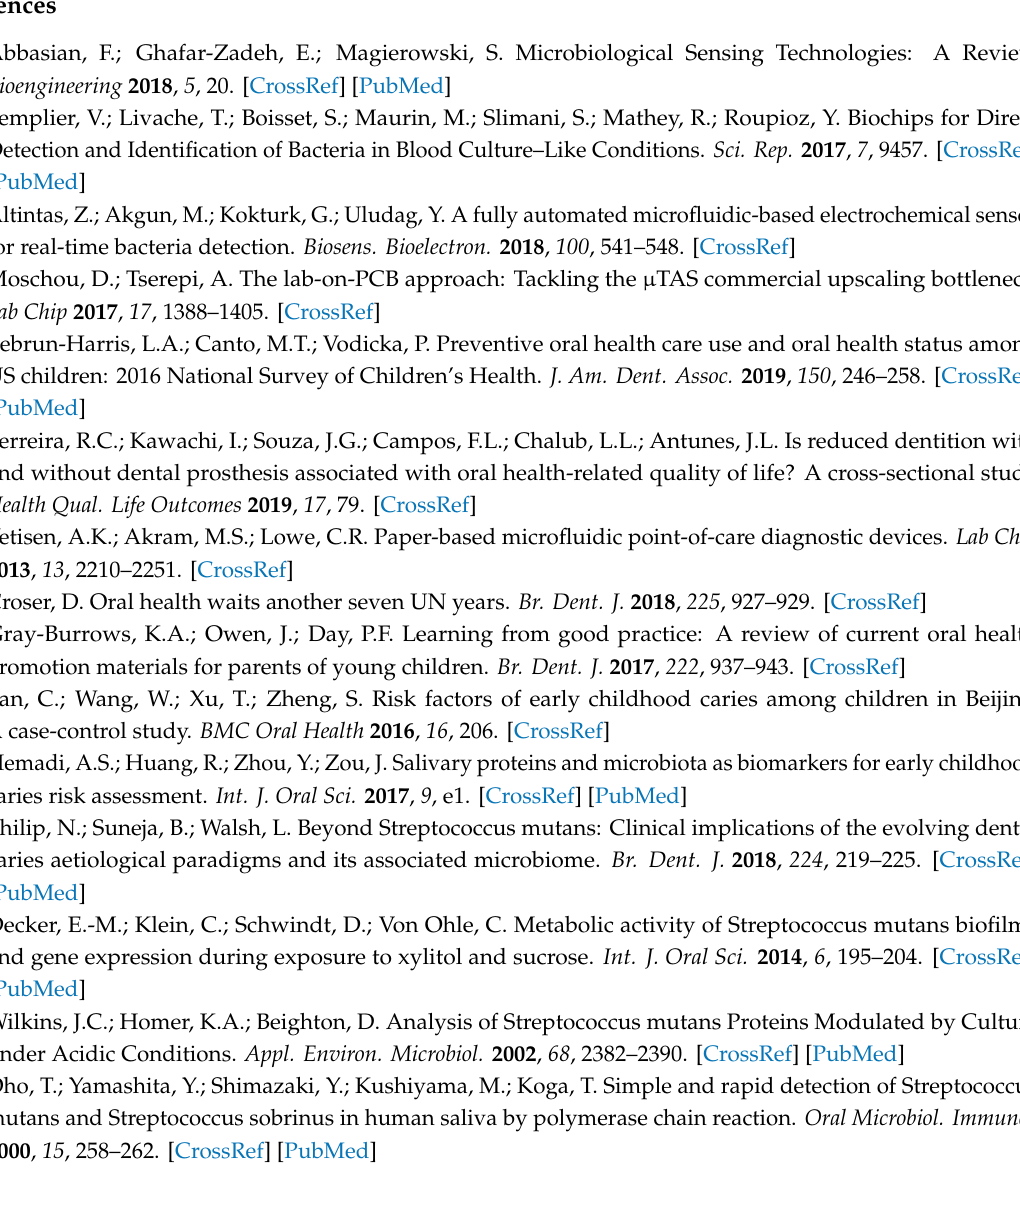
Figure S1: Selection and validation of the anti- S. mutans antibody by ELISA, Figure S2: Selection and validation of the anti- S. mutans antibody by